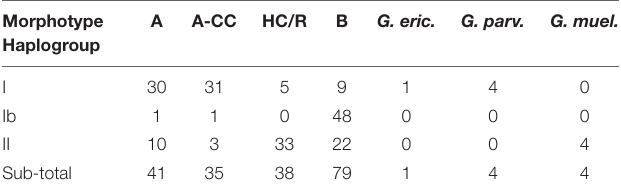
TABLE 3 | Correspondence among morphotypes and cox haplogroups of E. huxleyi from SE Pacific. Morphotype